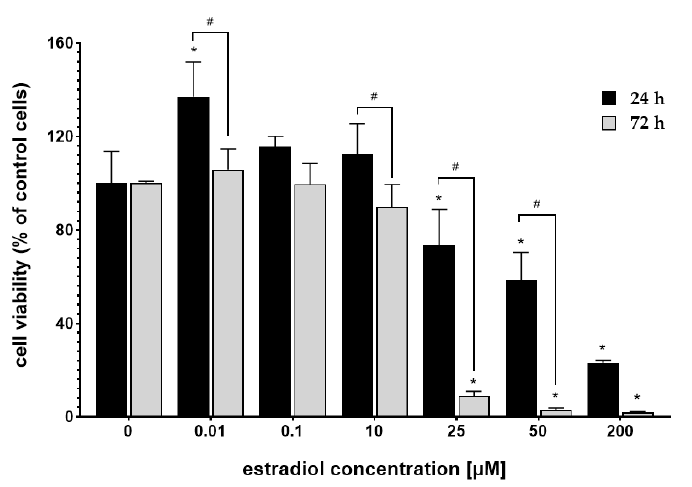
Figure 1. MDAH-2774 cells viability measured by the MTT assay after 24 h and 72 h incubation in different 17 β -estradiol concentrations. Notes: (mean ± SD) N = 3, * p < 0.05 compared to control, # p < 0.05 compared between different incubation times.